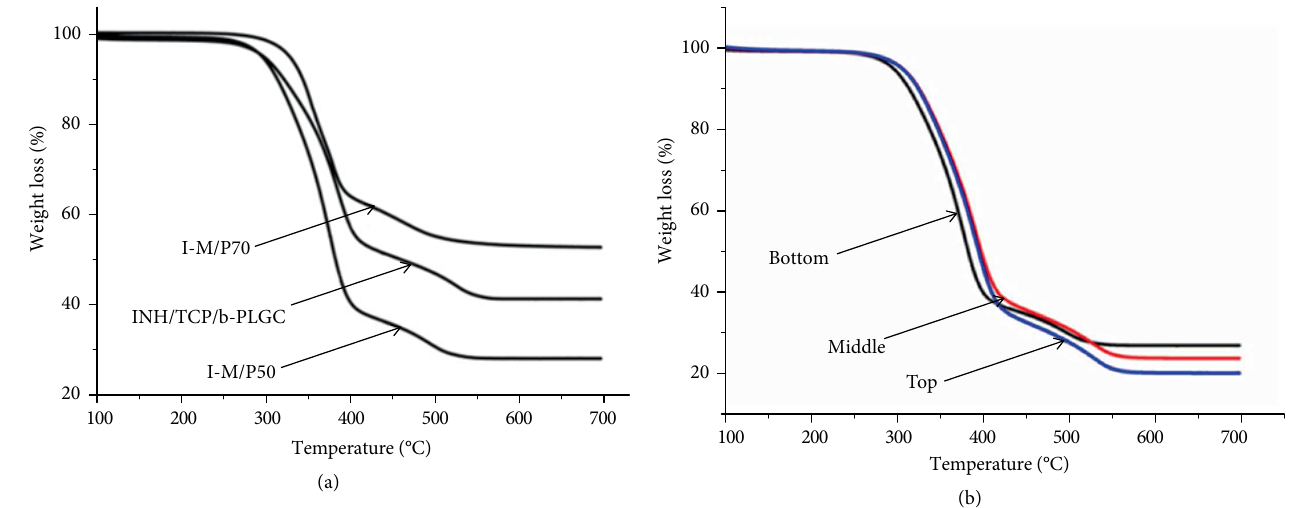
Figure 5: TGA curves of INH-loaded b -PLGC scaffolds with (a) different content of microparticles and (b) different parts of I-M/P50